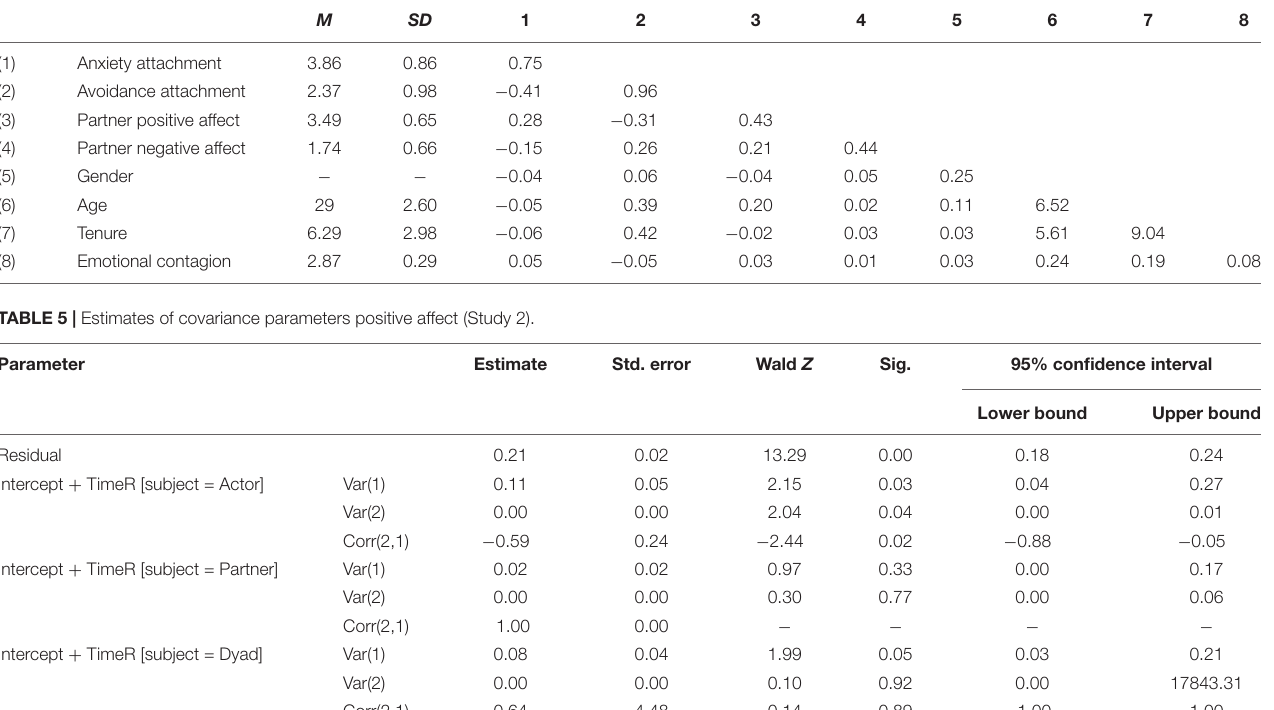
TABLE 4 | Variance-covariance of main variables (Study 2; k = 648 observations).